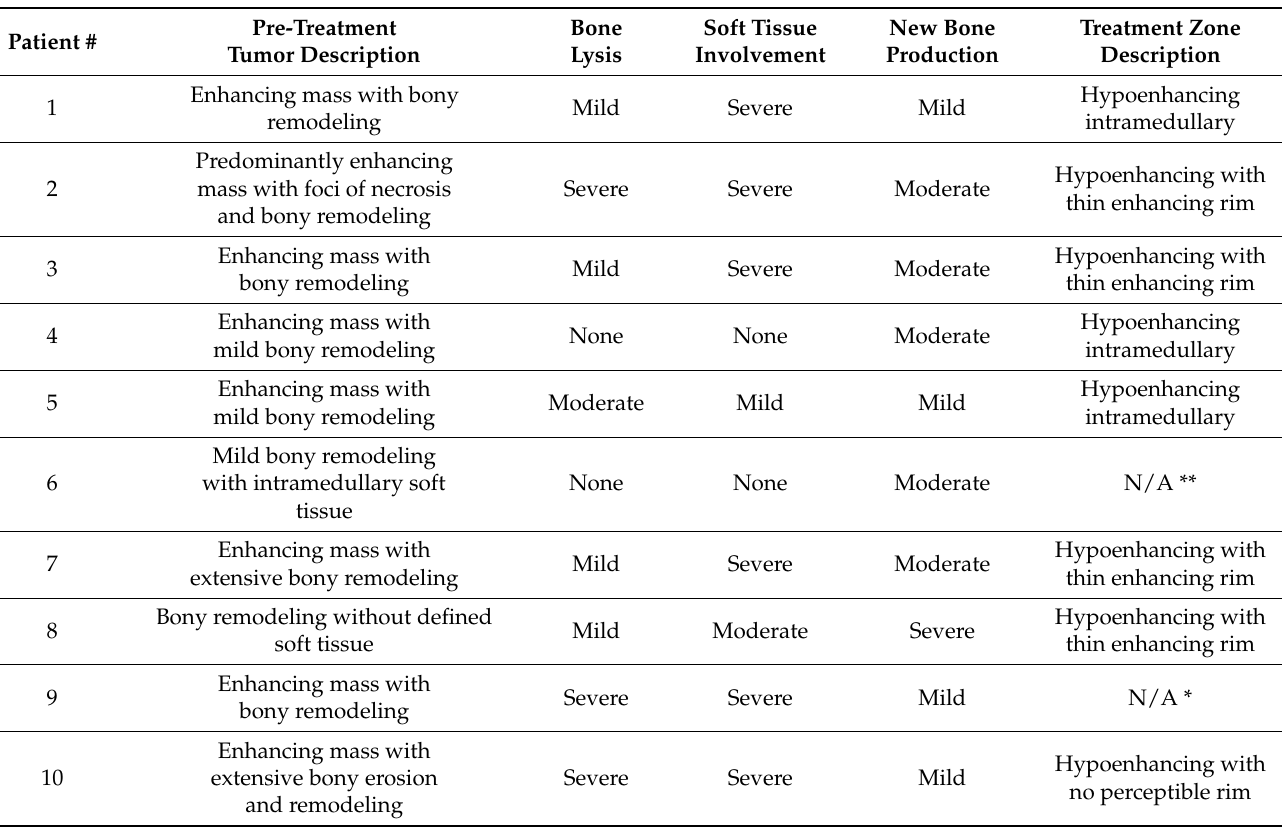
Table 4. Radiographic tumor and treatment zone characteristics. * Post-treatment CT not collected due to scheduling constraints. ** Treatment zone not